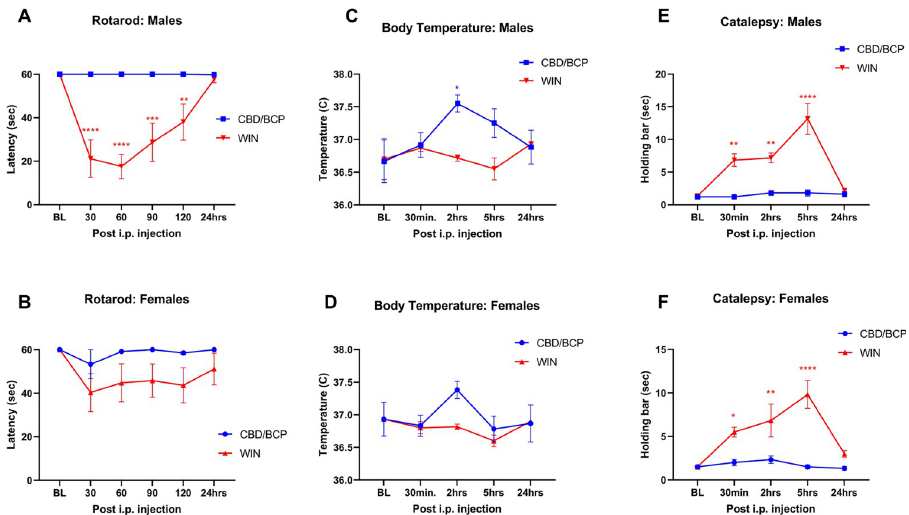
Fig 8. Side effects profiles for CBD and BCP combination in male and female rats. Time course showing the effect of maximum utilized antinociceptive dose combination of CBD (7 mg/kg) and BCP (35 mg/kg) compared with WIN 55212–2 (3 mg/kg) on rotarod latency in A) males and B) females, body temperature in C) males and D) females, respectively, and catalepsy bar latency in E) males and F) females (n = 6 per treatment group). Animals received a subcutaneous injection of WIN 55212–2 or an intraperitoneal injection and single oral administration of CBD:BCP following baseline determinations. � , �� , ��� , ���� denote p < 0.05, 0.01, 0.001 and 0.0001 compared to baseline for each treatment